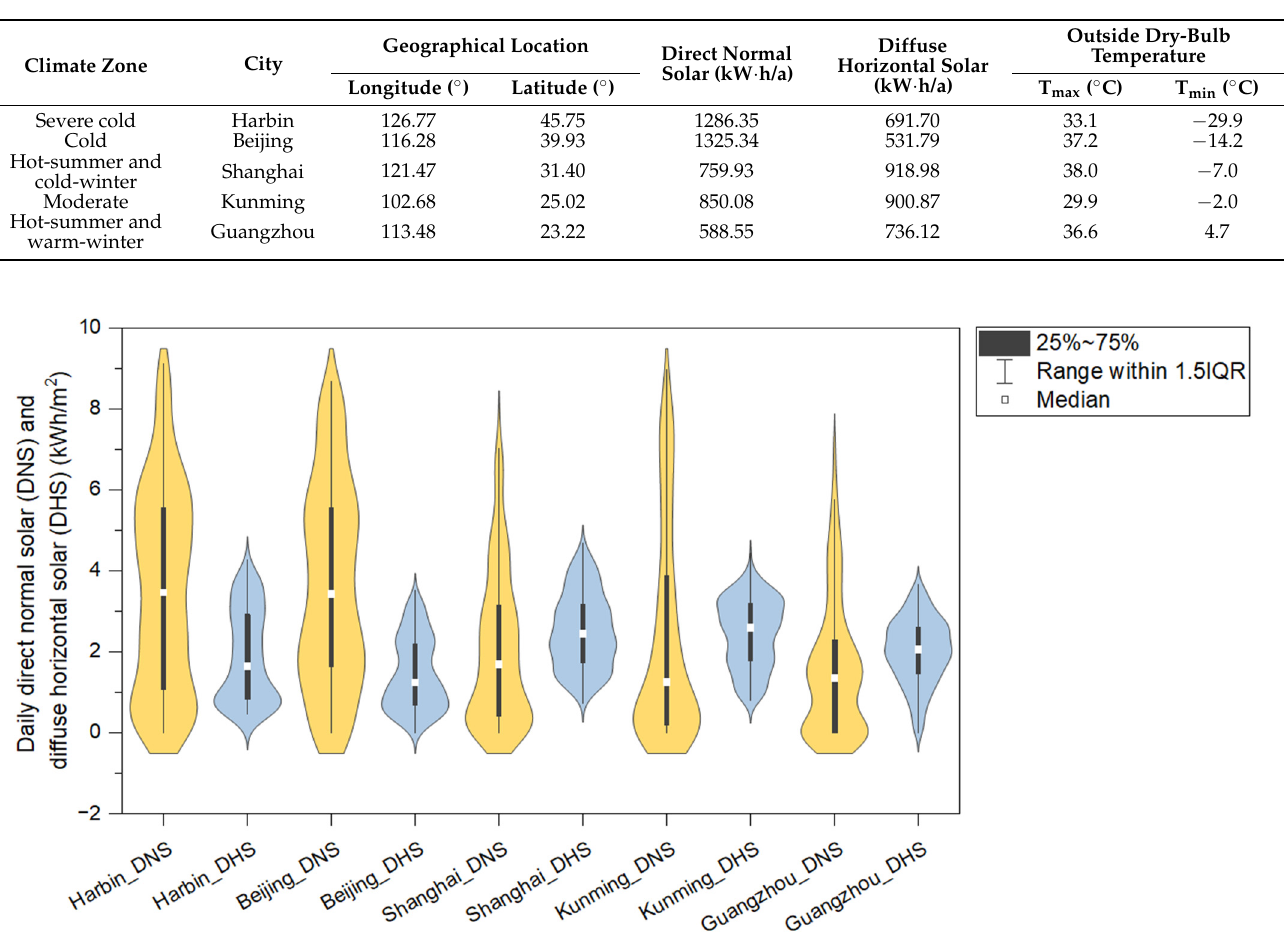
Figure 7. Comparison of available solar in five cities.